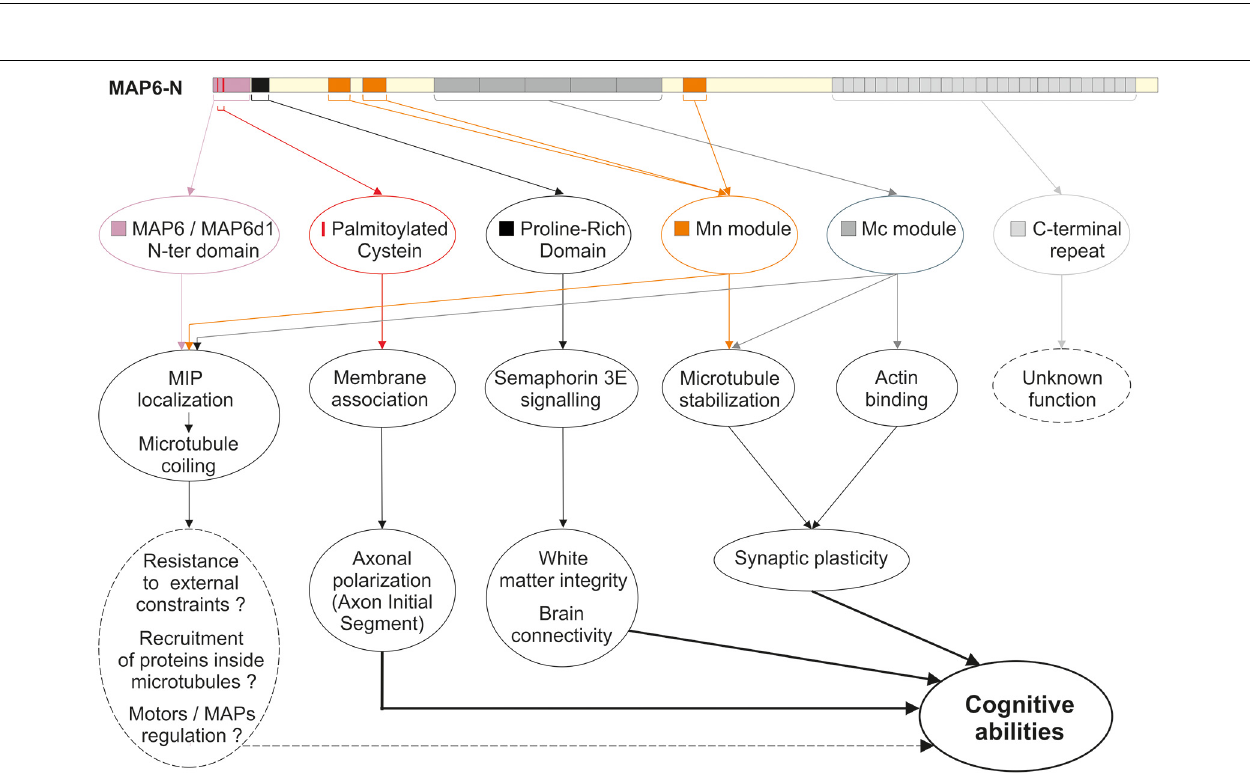
FIGURE 1 | MAP6 protein and its interactors. All the known MAP6 interactors (see Supplementary Table 1 ) are presented and grouped based on their functions.